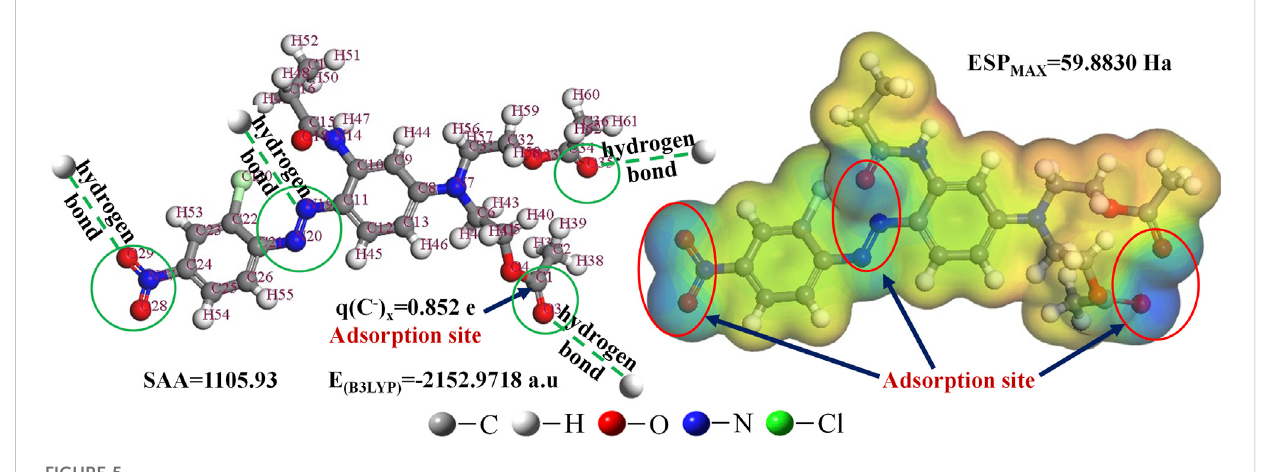
FIGURE 5 Removal mechanism of DR16 by AlCl 3 under alkaline